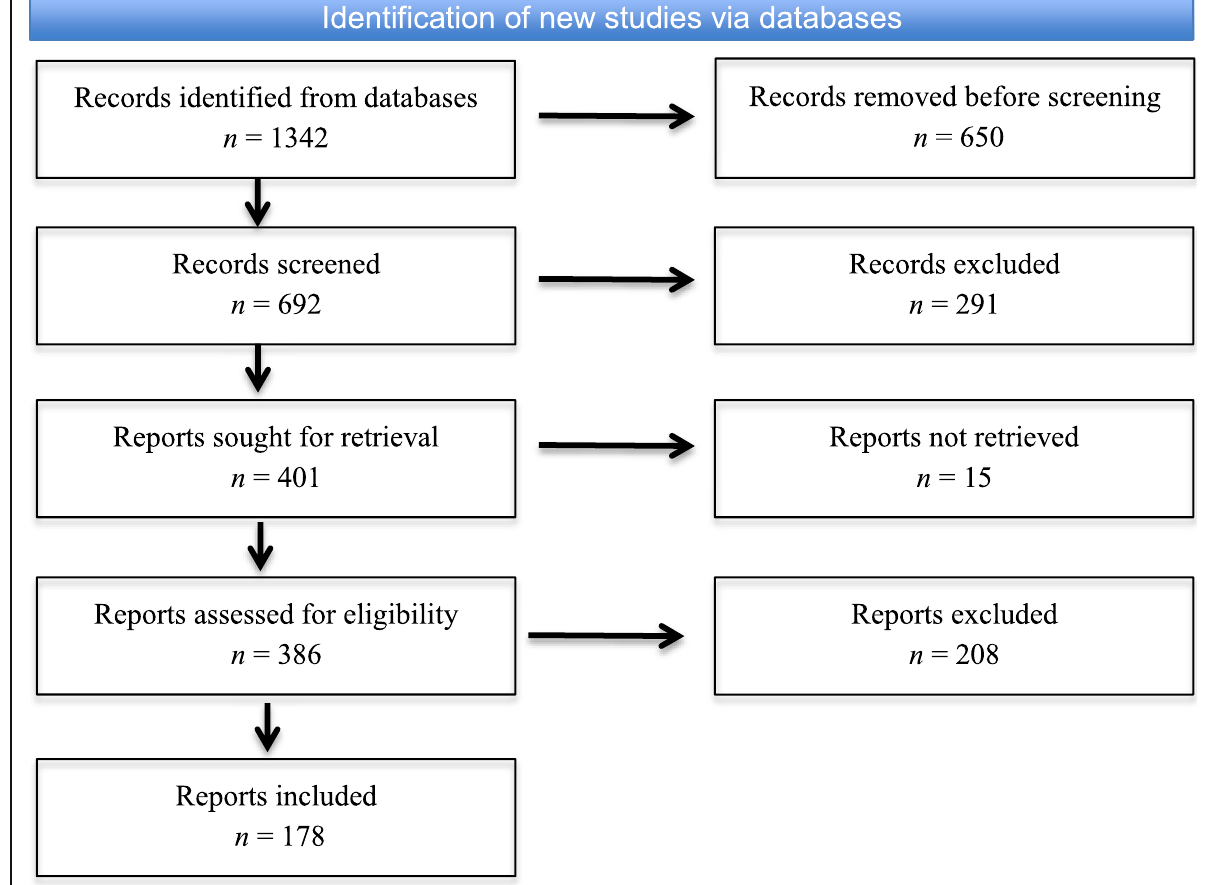
Fig. 1 The PRISMA flow diagram